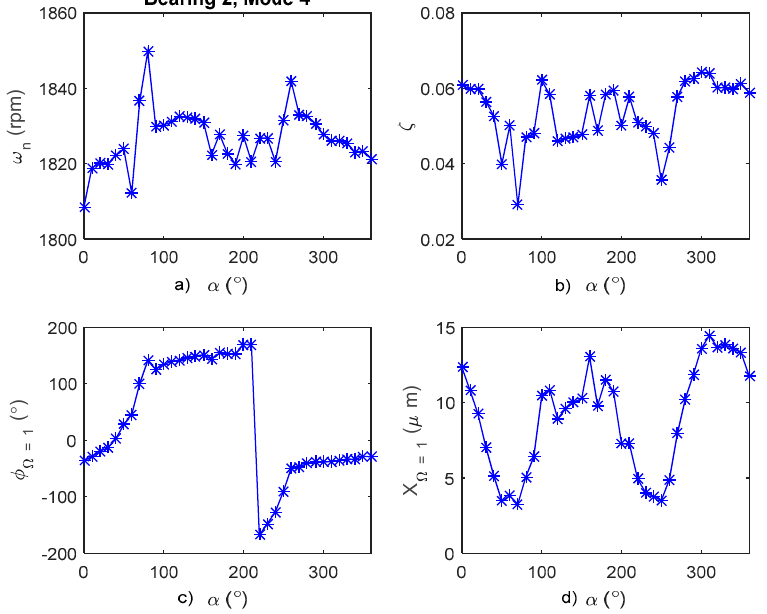
Figure 10. Identification of close modes in bearing 2 in field turbogenerator for ( a ) natural frequency, ( b ) damping ratio, ( c ) phase angle and ( d ) vibration amplitude at resonance.